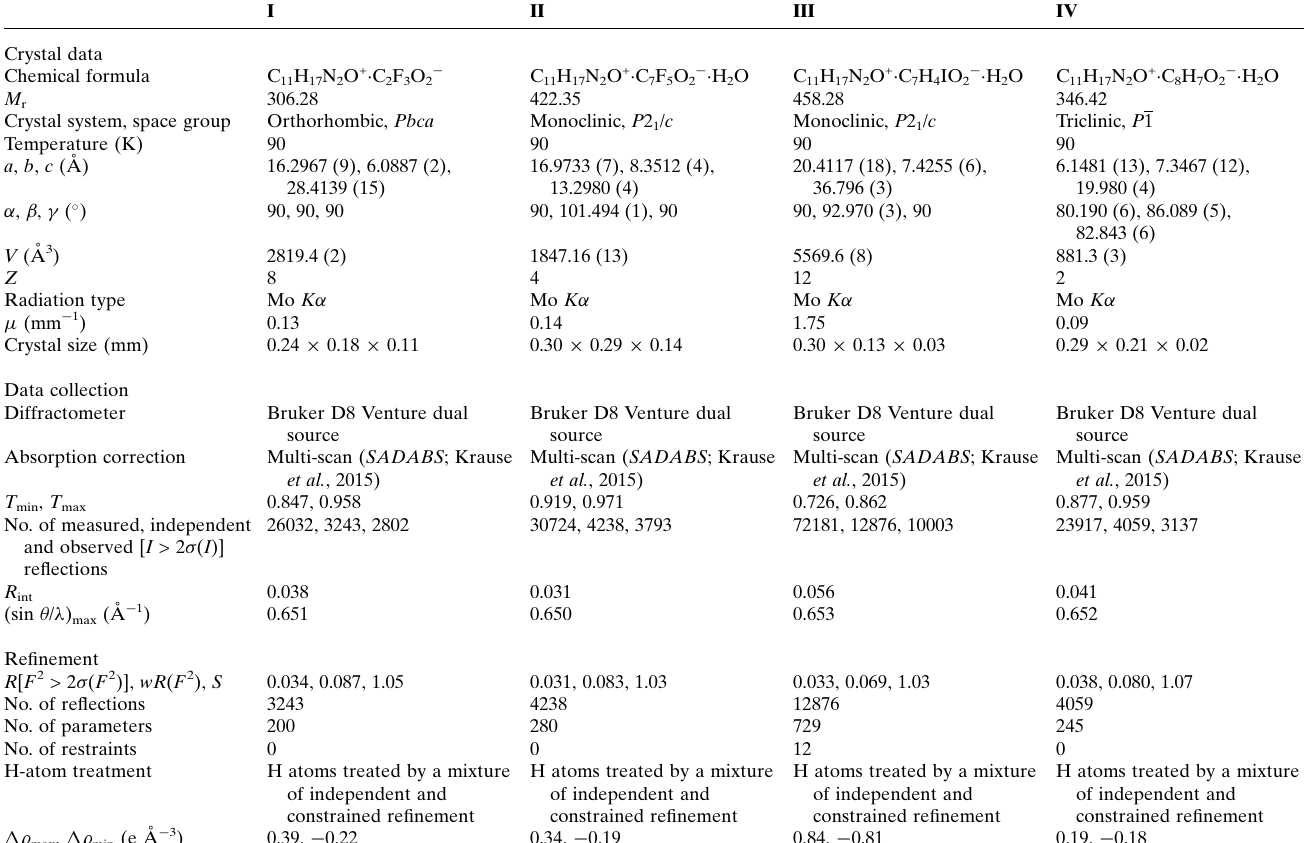
Table 5 Experimental details.